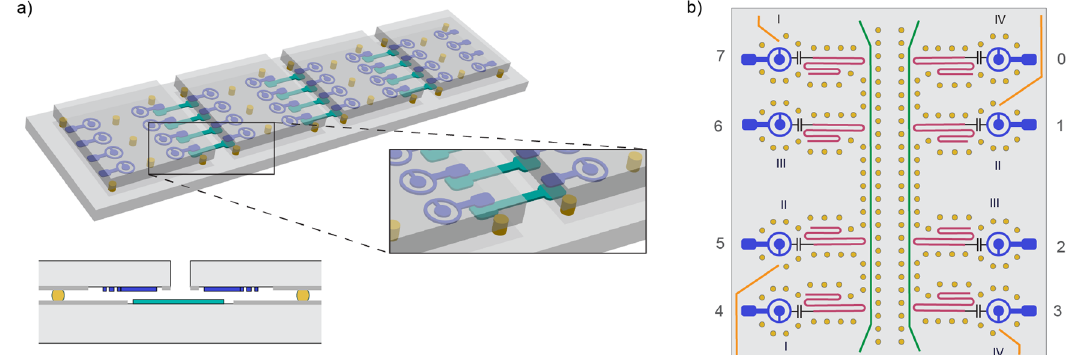
Fig. 1 Schematics (not to scale) illustrating the multi-core architecture. a Isometric view of the device assembly. The qubits (blue circular structures) are fabricated on the QuIC die and have one arm with a paddle-shaped coupler extending to the edge of the chip. The chips are fl ip-chip bonded onto the carrier chip using indium bump bonds (yellow) and the qubit couplers are aligned above couplers on the carrier chip (teal) as shown in the inset as well as the cross-sectional view. b False-colored schematic of a single QuIC including readout resonators and readout lines (magenta and green), indium bumps (yellow), fl ux bias lines (orange) and the qubits and paddles of the inter-chip couplers (blue). The physical qubits are labelled 0 – 7 while Roman numerals correspond to the design speci fi cation for the qubit (see Methods). Note that component geometries are not drawn exactly as fabricated: the schematic is intended primarily to depict the circuit layout as opposed to details into individual feature